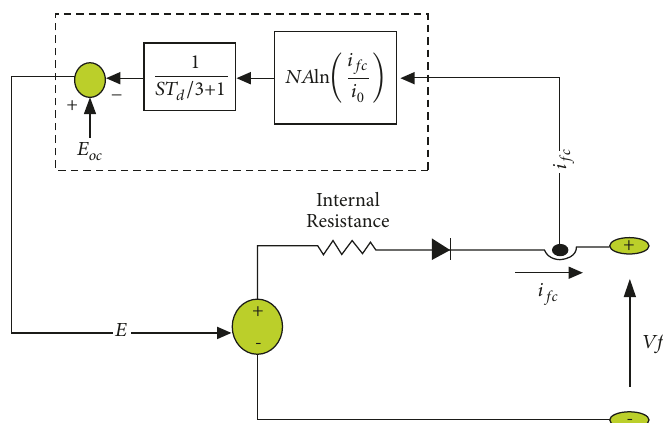
Figure 10: Fuel cell stack model